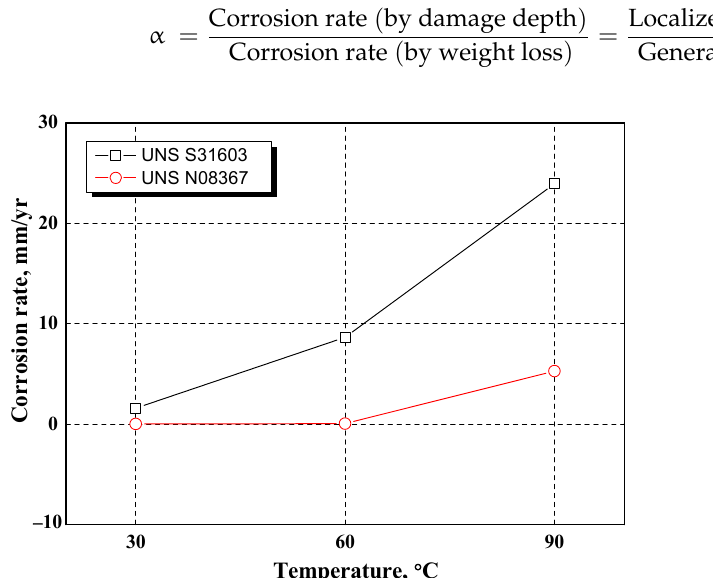
Figure 9. Corrosion rates (mm/yr) of UNS S31603 and UNS N08367 after the electrochemical experiments in a modified green death solution at different temperatures.